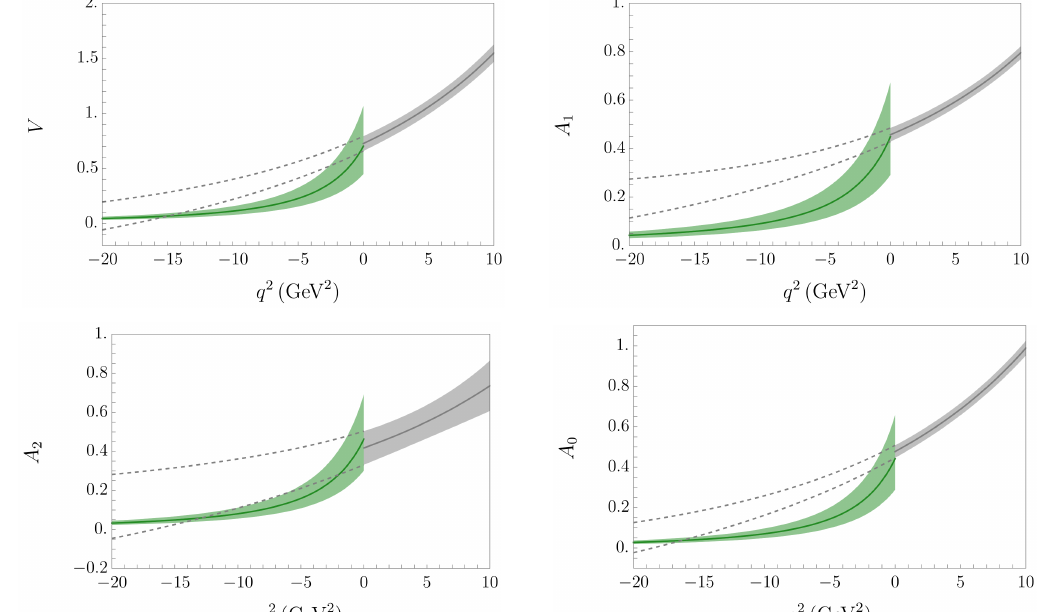
Figure 3 . Results for the vector and axial-vector B c → J/ψ form factors. The green band represents the 68% C.L. region for the sum rule results at q 2 < 0 . The gray bands are the 68% C.L. region for the lattice QCD predictions [4] at q 2 > 0 . The solid green and gray lines in the center show the median of the sum rules and lattice QCD results distribution,